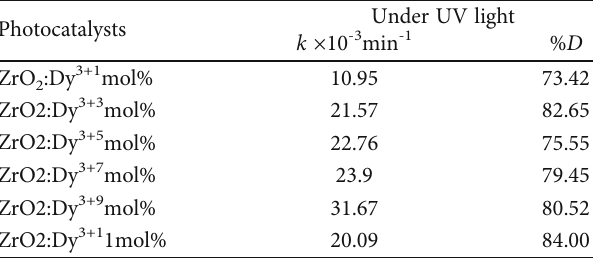
Figure 7: PL emission spectrum of ZrO excited at 353 nm. Table 2: Kinetic studies under UV light for ZrO2:Dy 3+ (1 – 11mol%)